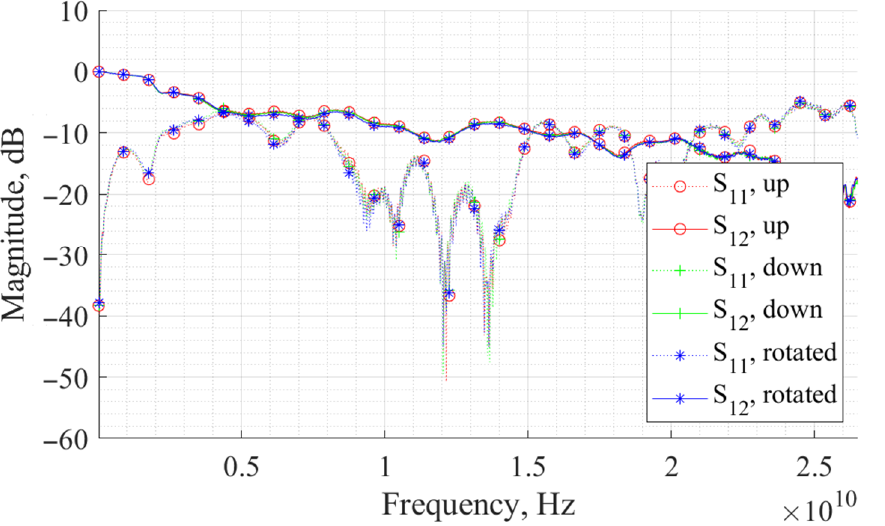
Figure 4. S parameters of the sample of the studied system: up—random orientation; down—the sample is upside down; rotated—the sample is rotated by about 90 degrees.